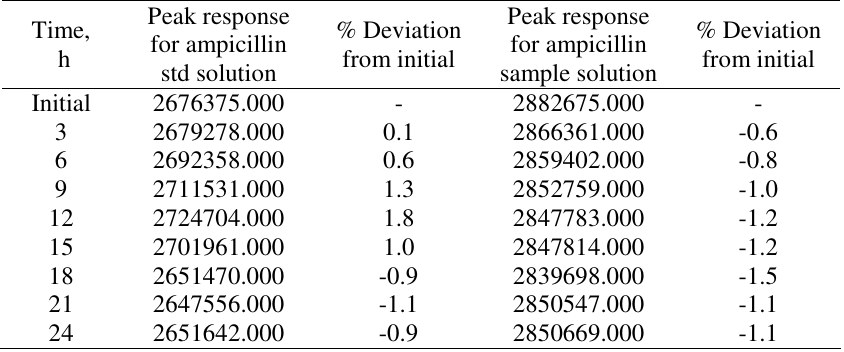
Table 6. Solution stability study analysis for ampicillin capsules dosage